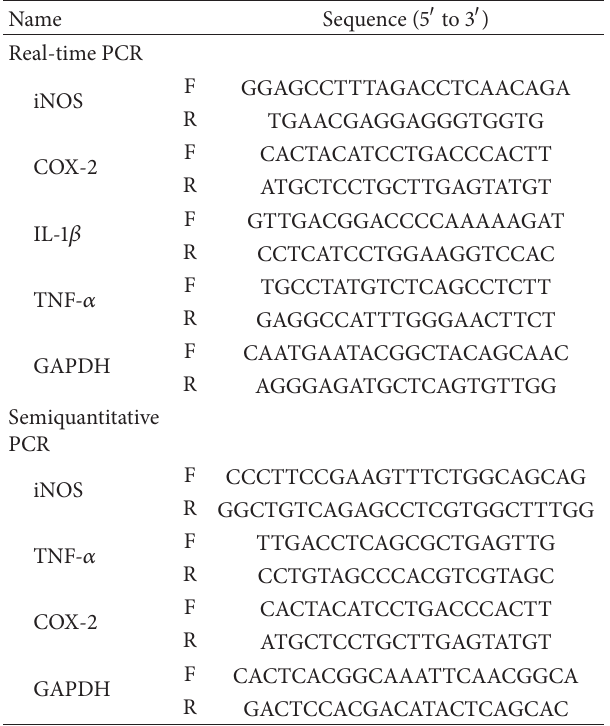
Table 1: Primer sequences used in RT-PCR